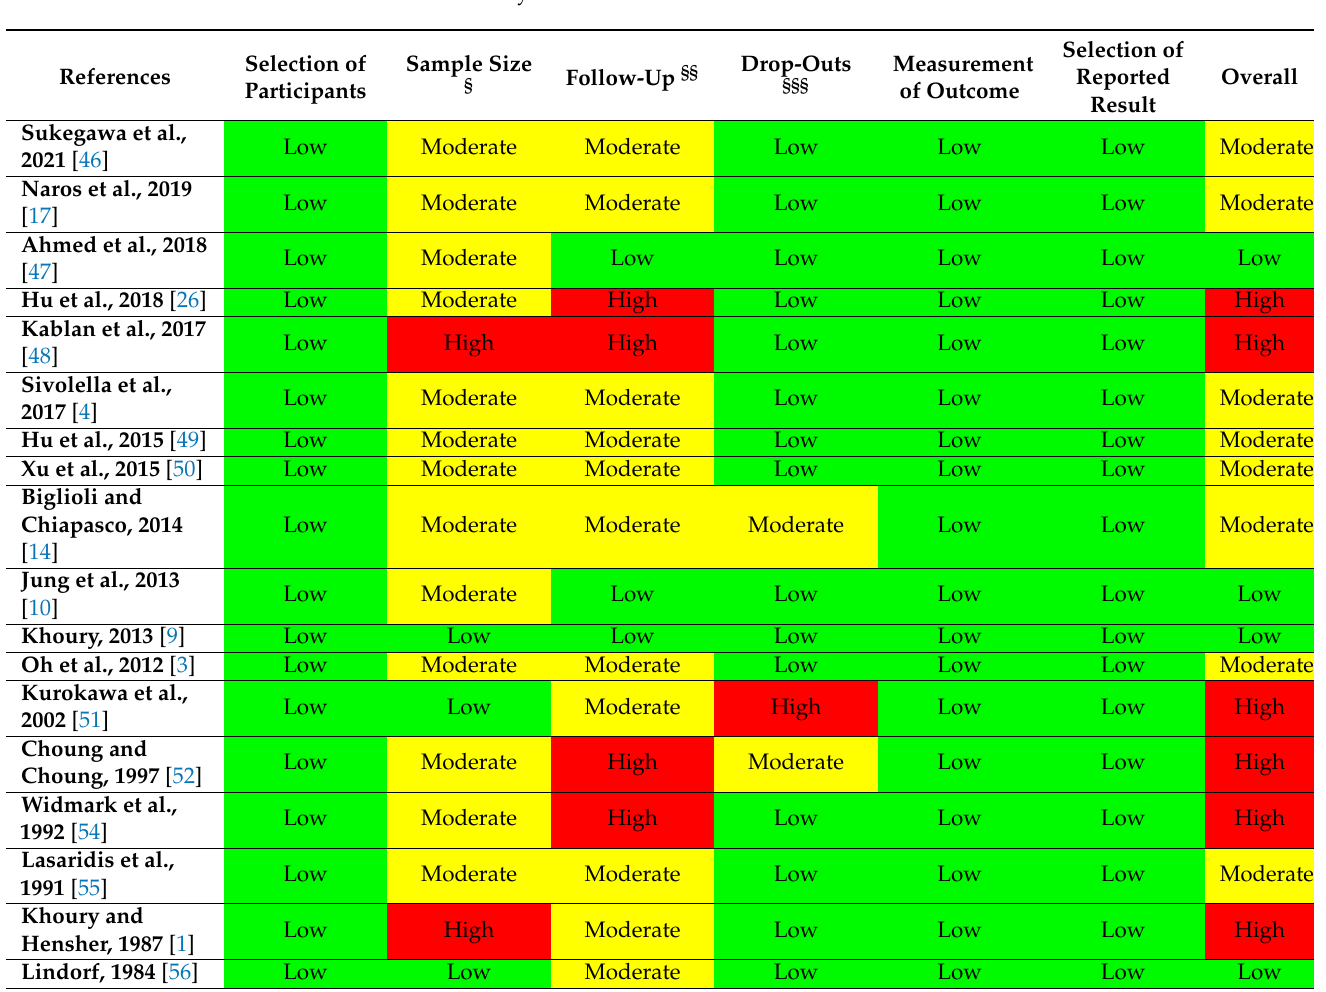
Table 6. Risk of bias assessment: reviewers’ judgments about each risk of bias item for each included observational